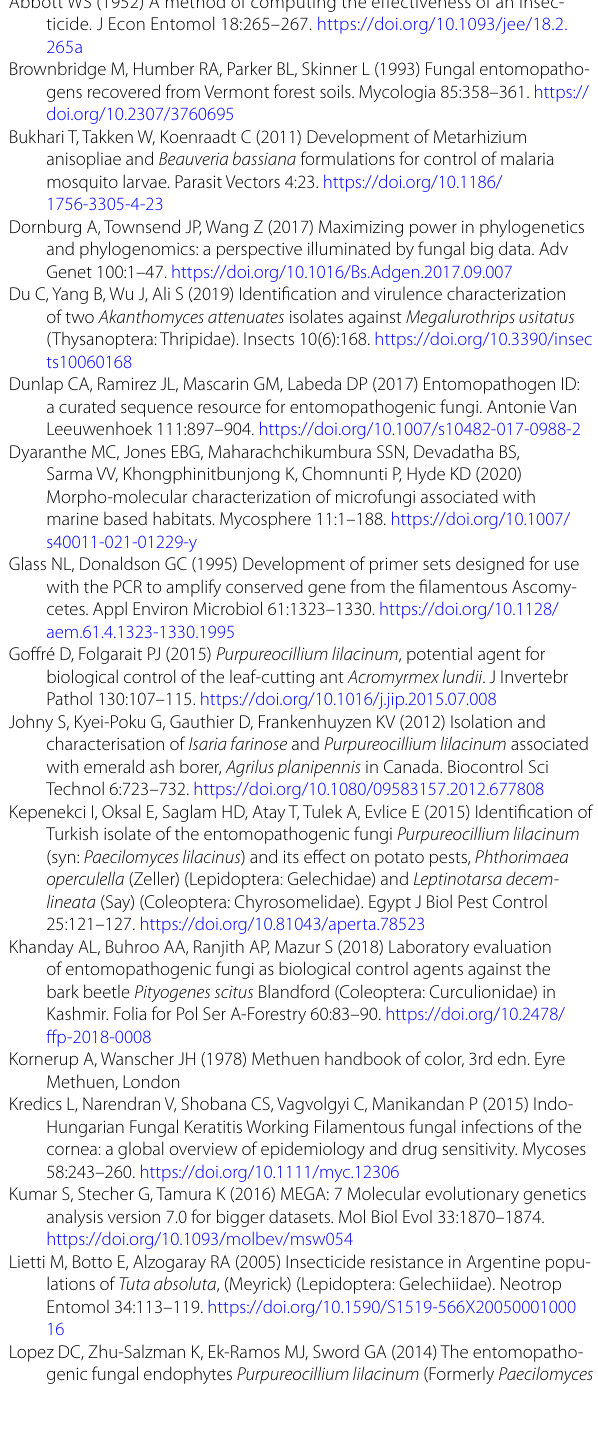
) of Purpureocillium lilacinum 50